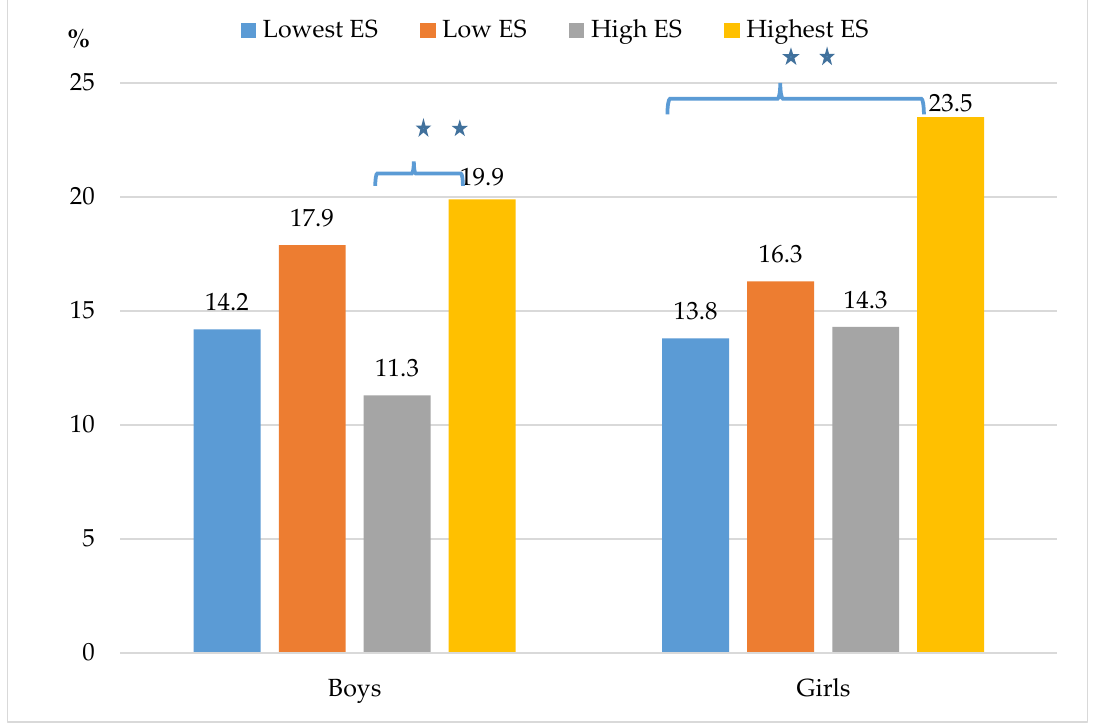
Figure 1. Rates of boys ( n = 849) and girls ( n = 1152) meeting the leisure-time walking activities (5 × 60 min walking per week) recommendations by different levels of perceived neighborhood environmental safety (ES) (** = p < 0.01).